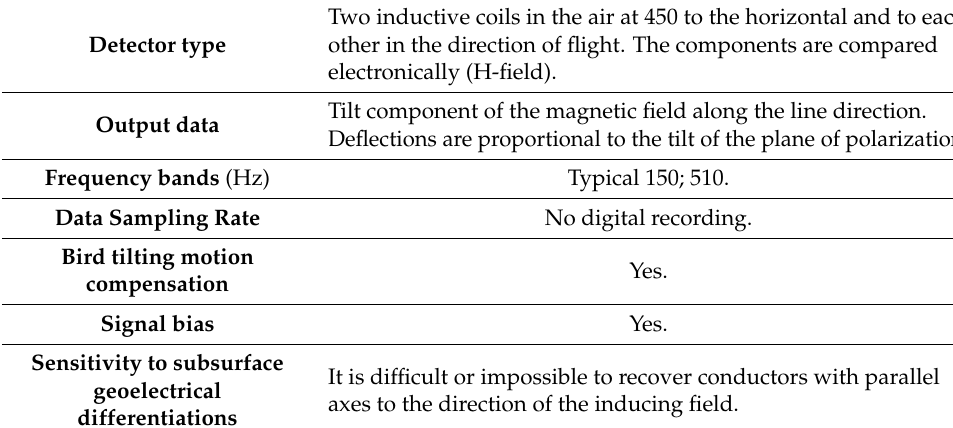
Table 1. Technical specifications of AFMAG system